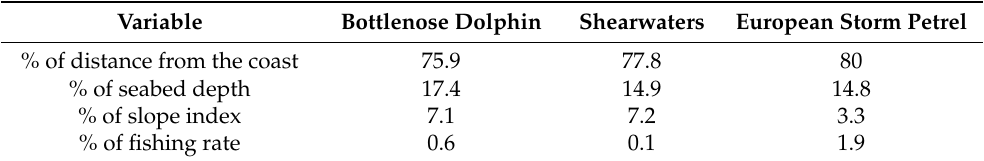
Table 5. Percentage contribution that each of the variables tested (distance from the coast, seabed depth, slope index, fishing rate) has on the distribution of bottlenose dolphins, shearwaters, and European storm petrels.